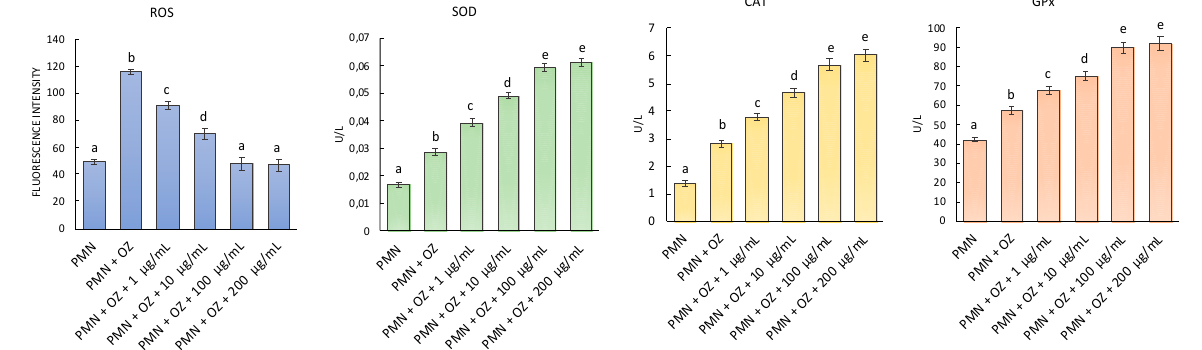
Figure 7. ROS generation and activities of antioxidant enzymes in PMN treated with EO of F. vulgare subsp. vulgare var. vulgare at the concentrations of 1, 10, 100, 200 µ g/mL with or without OZ (500 µ g/mL). Data were presented as mean and standard error and they were analyzed with a paired t-test. Bars not accompanied by the same letter were significantly different at p <